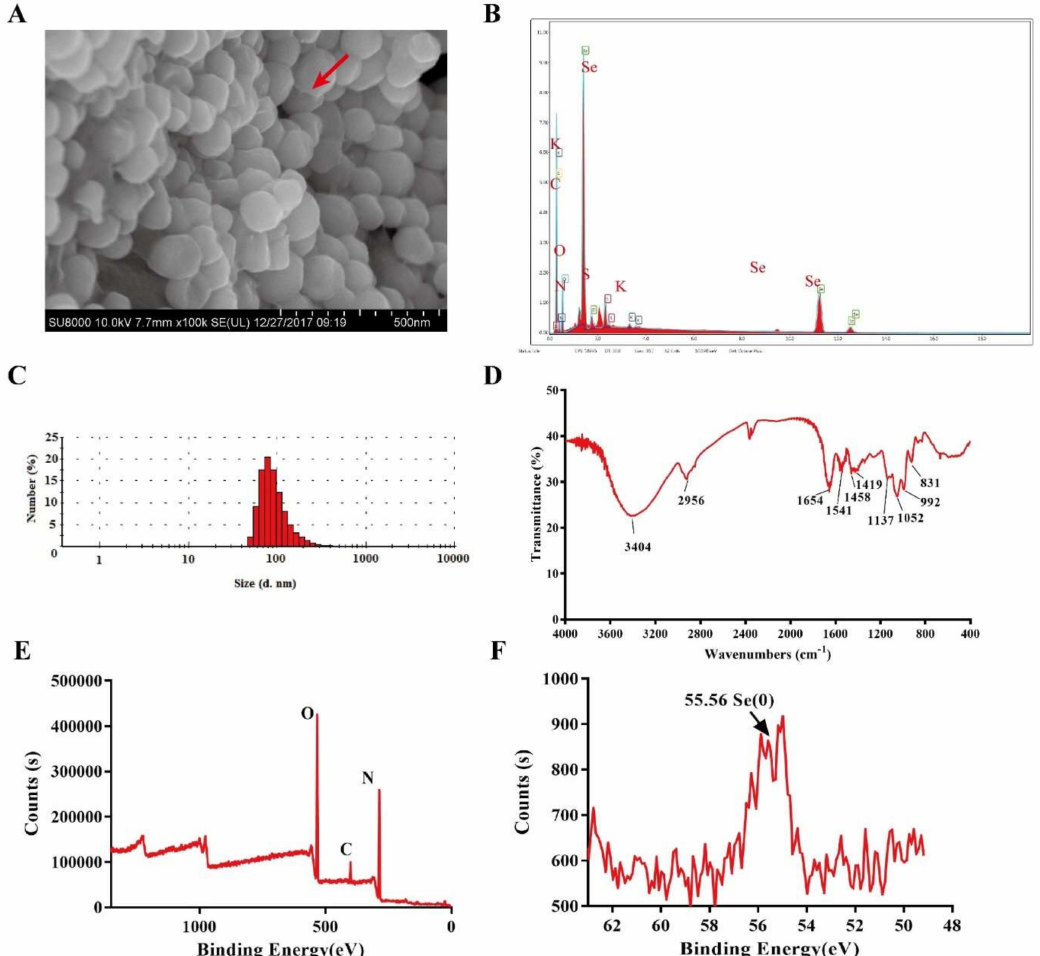
Figure 2. Characterization of Bio-SeNPs. The SEM ( A ) and EDS ( B ) showed that the SeNPs were irregular spheres with a high content of elemental Se. The DLS spectrum ( C ) indicated the diameters of the nanoparticles. The FT-IR ( D ) and XPS ( E , F ) spectra exhibited proteins, lipids, inorganic ions and Se(0) in